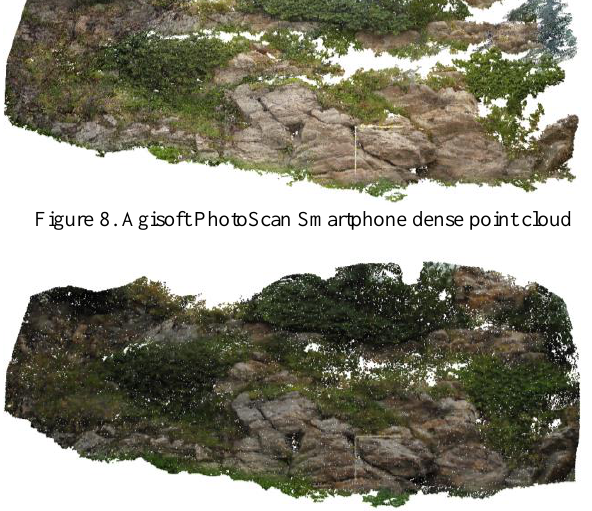
Figure 9. Agisoft PhotoScan Nikon dense point cloud